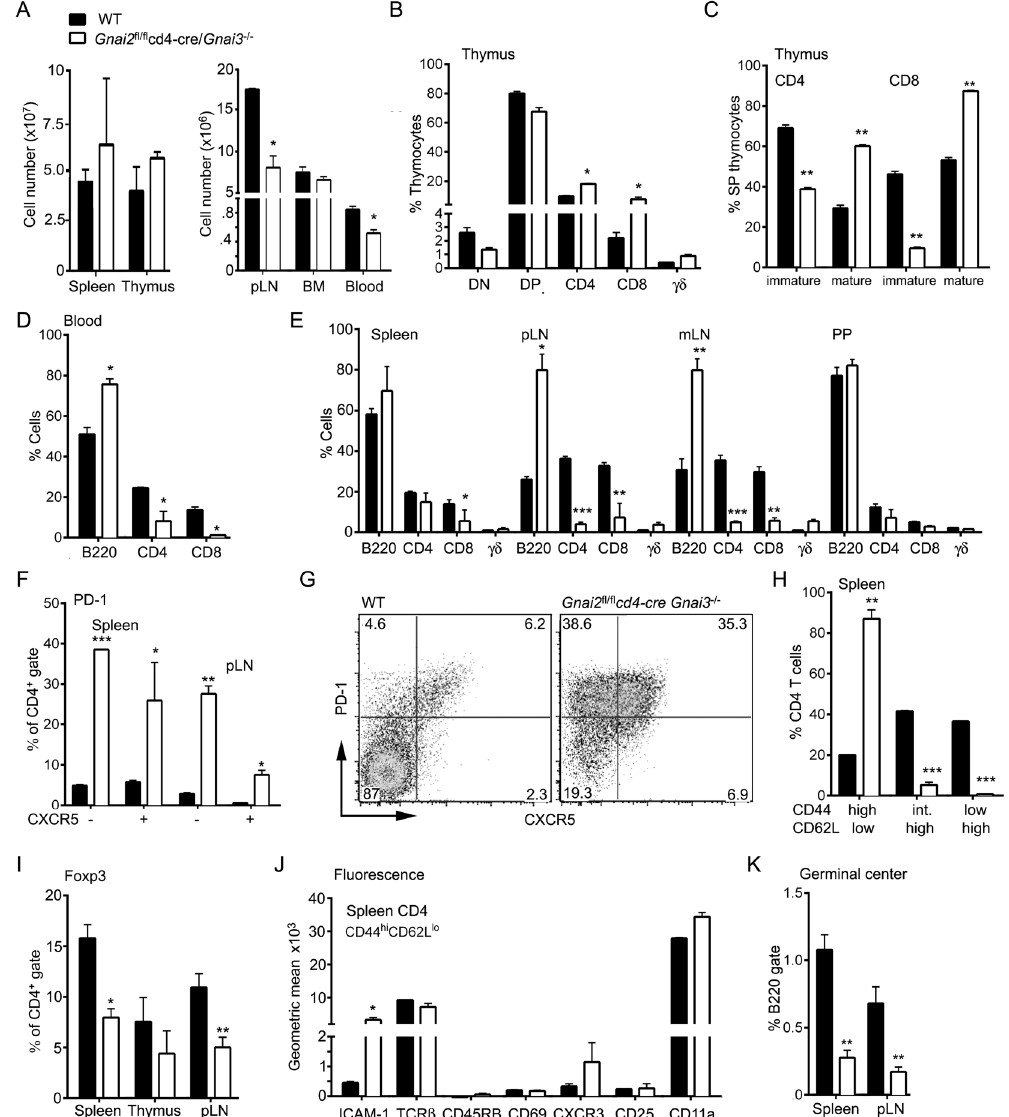
Figure 3. Consequences of deleting Gnai2 in DP thymocytes of mice that lack Gnai3 on T cell development and distribution. ( A ) Cell numbers in different lymphoid compartments. Number of cells in the lymphocyte gate. ( B ) Distribution of thymocyte subsets as assessed by flow cytometry. ( C ) Distribution of mature and immature SP CD4 and CD8 thymocytes. ( D ) Distribution of lymphocytes in the blood. ( E ) Distribution of lymphocytes in spleen, peripheral lymph node (pLN), mesenteric lymph nodes (mLN), and Peyer’s patches (PP). Axillary and inguinal lymph node cells were pooled in the pLN analysis. All visible PP were pooled for the analysis. ( F ) PD-1 and CXCR5 expression on CD4 cells from spleen and pLN of indicated mice. ( G ) Flow cytometry pattern of PD-1 versus CXCR5 expression on spleen CD4 cells from WT and DKO mice. ( H ) CD44 and CD62L expression on spleen CD4 T cells. ( I ) Percentage of Foxp3 CD4 T cells in the spleen, thymus, and pLN. ( J ) Comparison of indicated cell surface markers on CD44 hi CD62L lo splenic CD4 T cells. Data presented as a geometric mean. ( K ) Distribution of germinal center B cells in spleen and pLNs. % of B220 positive cells that express high levels of FAS, GL7, and low levels of CD38. Data represents the analysis of a minimum of 3 mice of each genotype repeated at least three times. * p < 0.05, ** p < 0.005 and *** p < 0.0005 (Student’s t